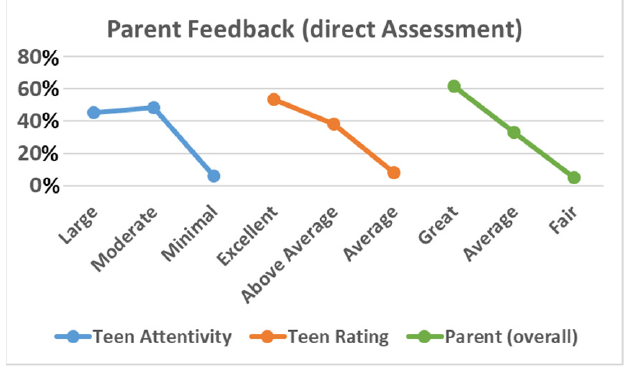
Figure 19. Parent (direct) Assessment Likert-style feedback.